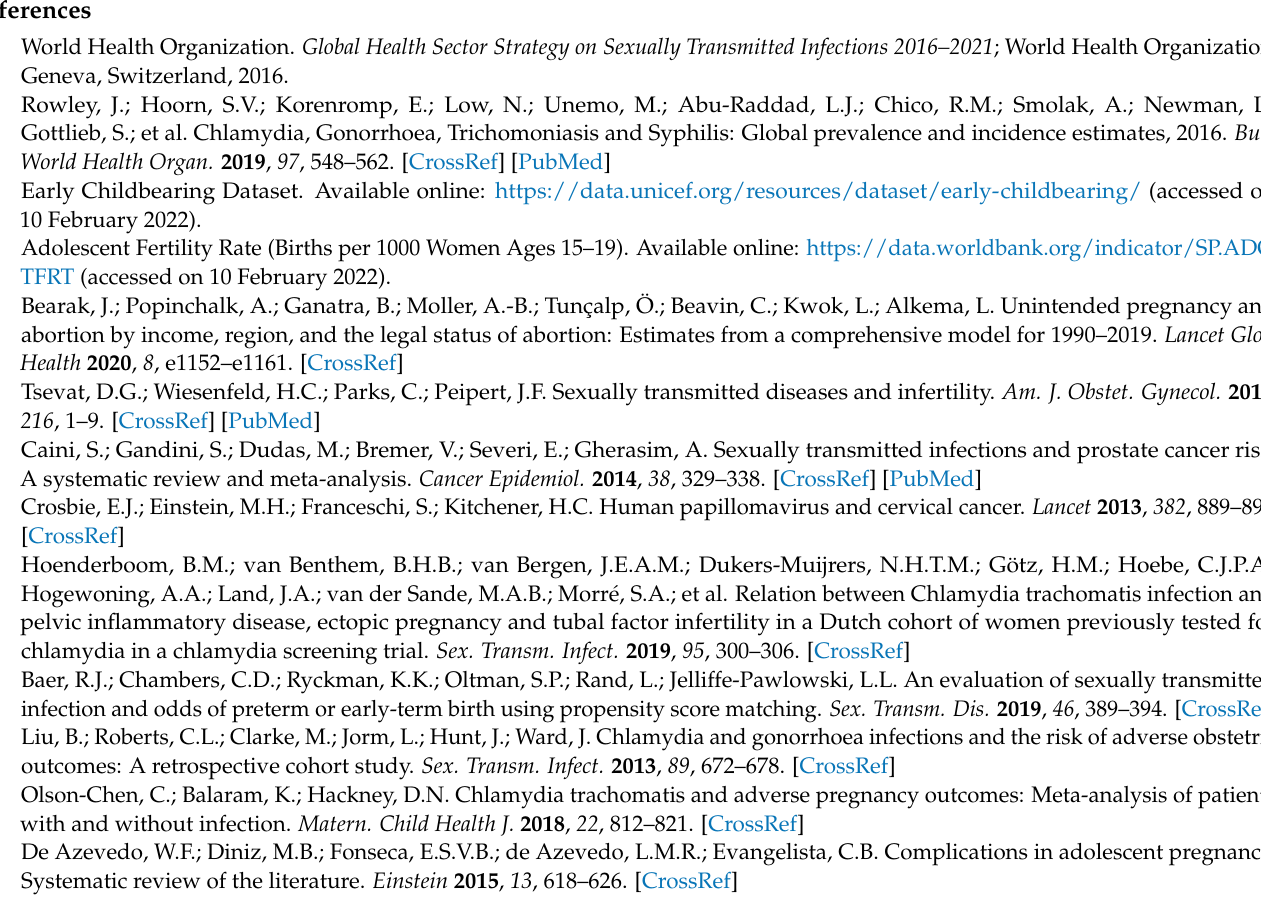
Table S2: Adverse childhood experiences, born to a teenage mother and sexual health